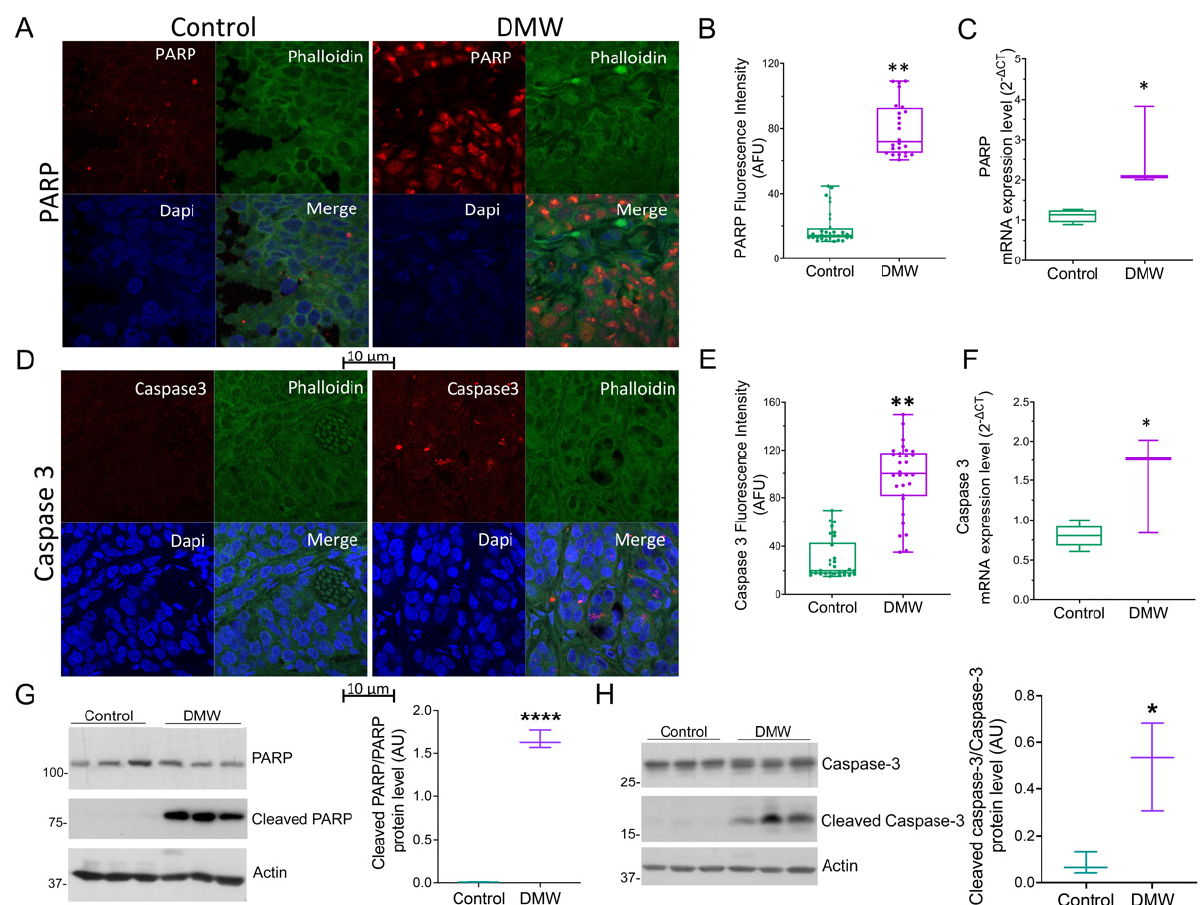
Figure 4. DMW promotes apoptosis activation in a xenograft model of colorectal cancer. ( A – C ) PARP and ( D – F ) caspase 3 protein and mRNA expression level determined by immunofluorescence and quantitative real-time PCR in control and DMW-treated mice. Fluorescence intensity determination, reported as boxplots representing the densitometric mean values of arbitrary fluorescence units (AFU). ( G , H ) Western blot analysis and densitometric analysis for PARP, cleaved PARP, caspase-3 and cleaved caspase-3 detection in tissues from control and DMW-treated mice. Signals were normalised as cleaved PARP/PARP and cleaved caspase-3/caspase-3 ratios. Data represent the mean ± SEM of three individual xenograft tissues. * p < 0.05, ** p < 0.01 and **** p < 0.0001 vs. control mice.